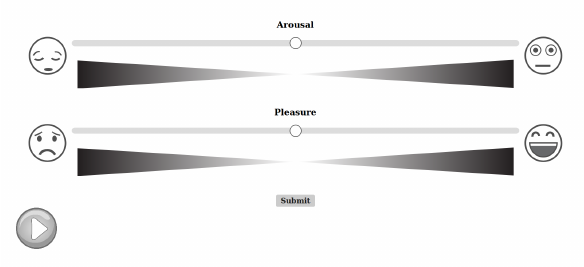
Figure 1: The adapted Affective Slider interface for collecting va- lence and arousal ratings. Note that the valence slider is labeled as "Pleasure", to convey the concept of valence in a more intuitive manner for the participants.